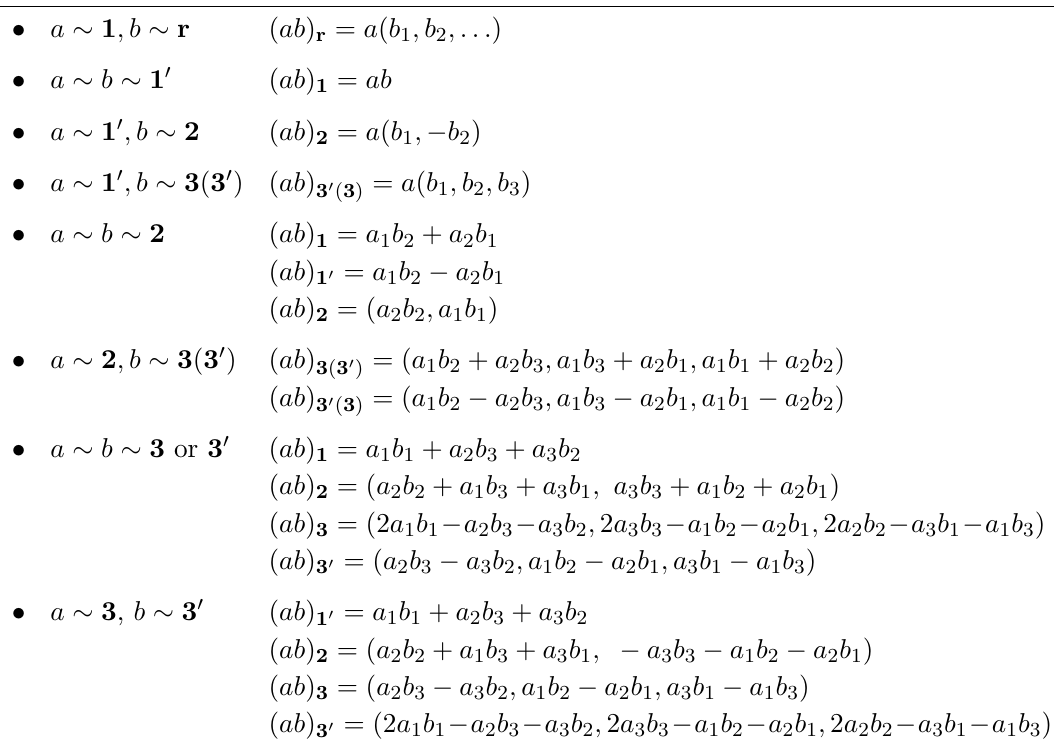
Table 3 . Kronecker products and Clebsch-Gordan (CG) coe(cid:14)cients of S 4 . r represents any irrep of S 4